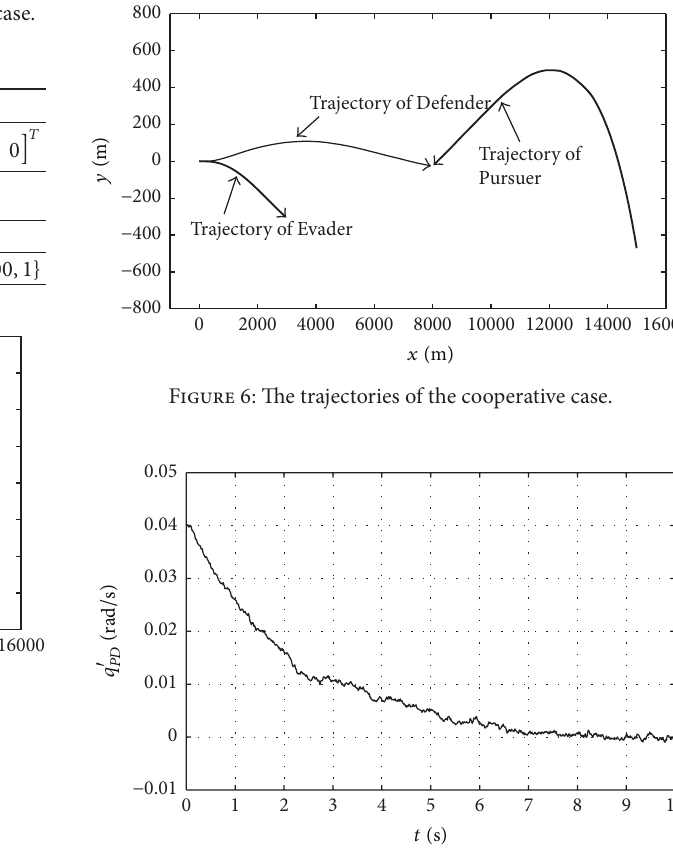
Figure 7: The LOS angular rate of cooperative case.